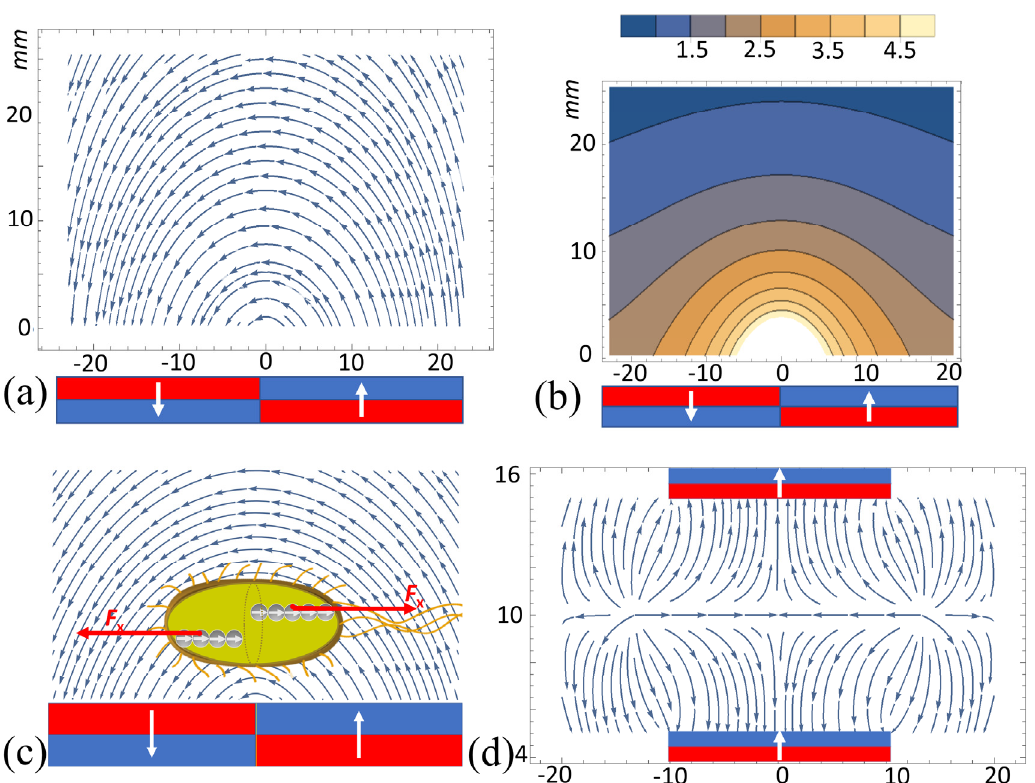
Figure 10. Magnetic field distributions and bacterial division. ( a ) Vector field of the magnetic field strength, H (the blue arrows). ( b ) Spatial distribution of its modulus above the two magnets of the lateral half size; a 1 = 23 mm and thickness 2 a 3 = 10 mm. The field was calculated in the plane 0.2 mm above the top of the magnets. The white arrows show the directions of the magnetizations of the magnets. The legend shows the values of │ H │ / M . ( c ) Bacterial division by the magnetic gradient forces and the magnetic field distribution (blue arrows); the red arrows are the x -components of the forces acting on the BMN chains in the magnetic system shown in Figure 10. ( d ) Vector field of the magnetic gradient in unit of the cell incubator shown in Figure 1 (the horizontal and vertical axes are the x- and z-coordinates, respectively).